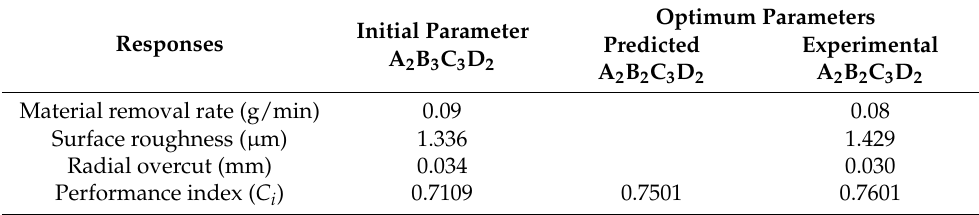
Table 10. Results of machining responses as per initial and optimal machining